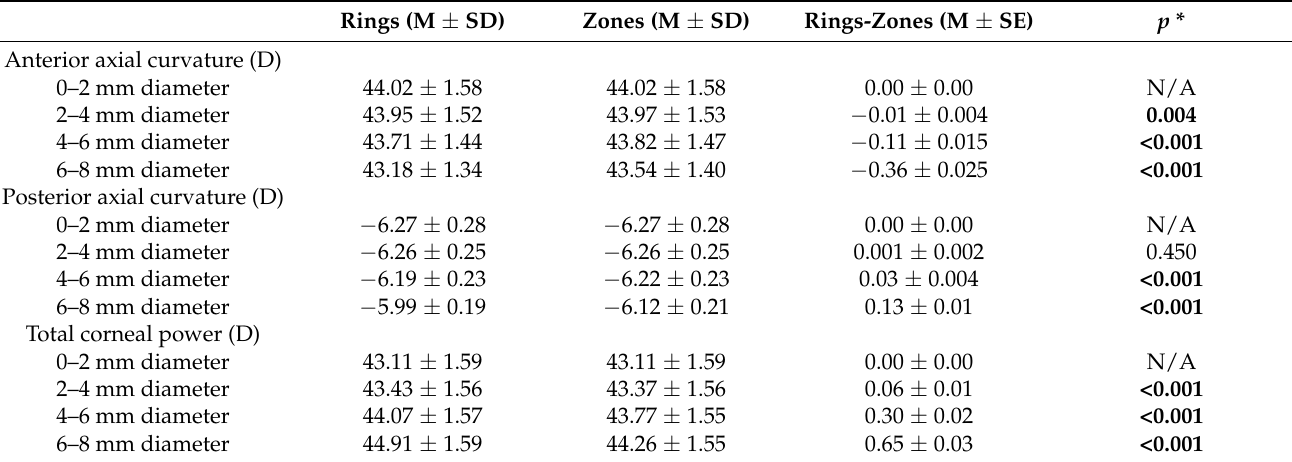
Table 1. Mean anterior axial curvature, posterior axial curvature, and total corneal power of different zones and rings centered on the